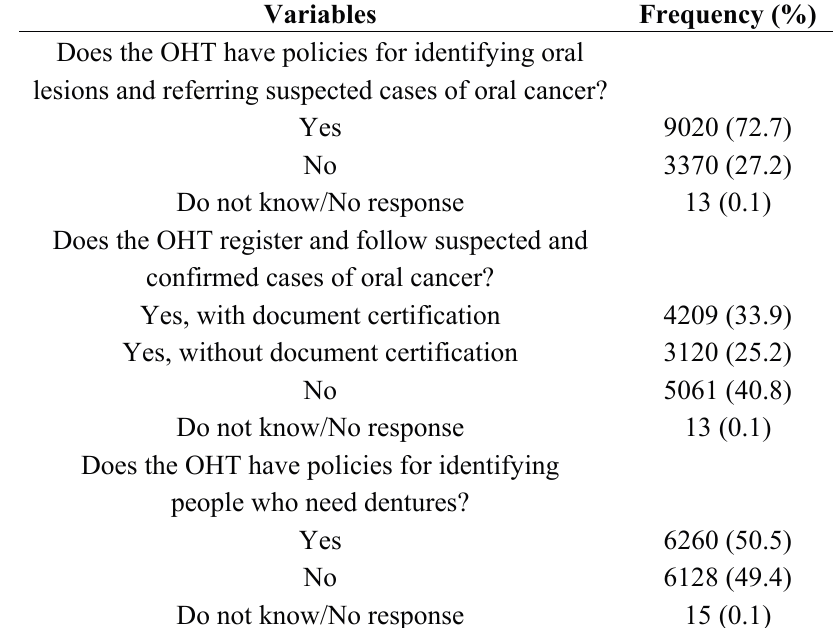
Table 3. Oral health surveillance actions performed by oral health teams in Brazil, 2012.